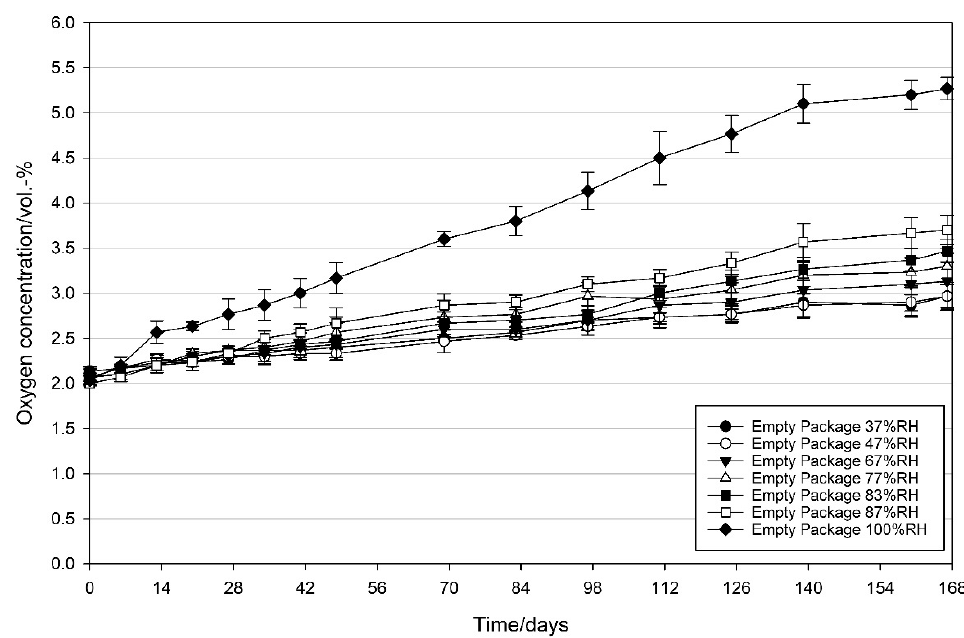
Figure A2. Oxygen concentration in empty packages stored at 21 ◦ C, and 37–100% RH in the package. Packed under modified atmosphere (MAP, 2 vol.-% O 2 , rest N 2 ; headspace 250 mL). Mean values and standard deviation (n = 3).